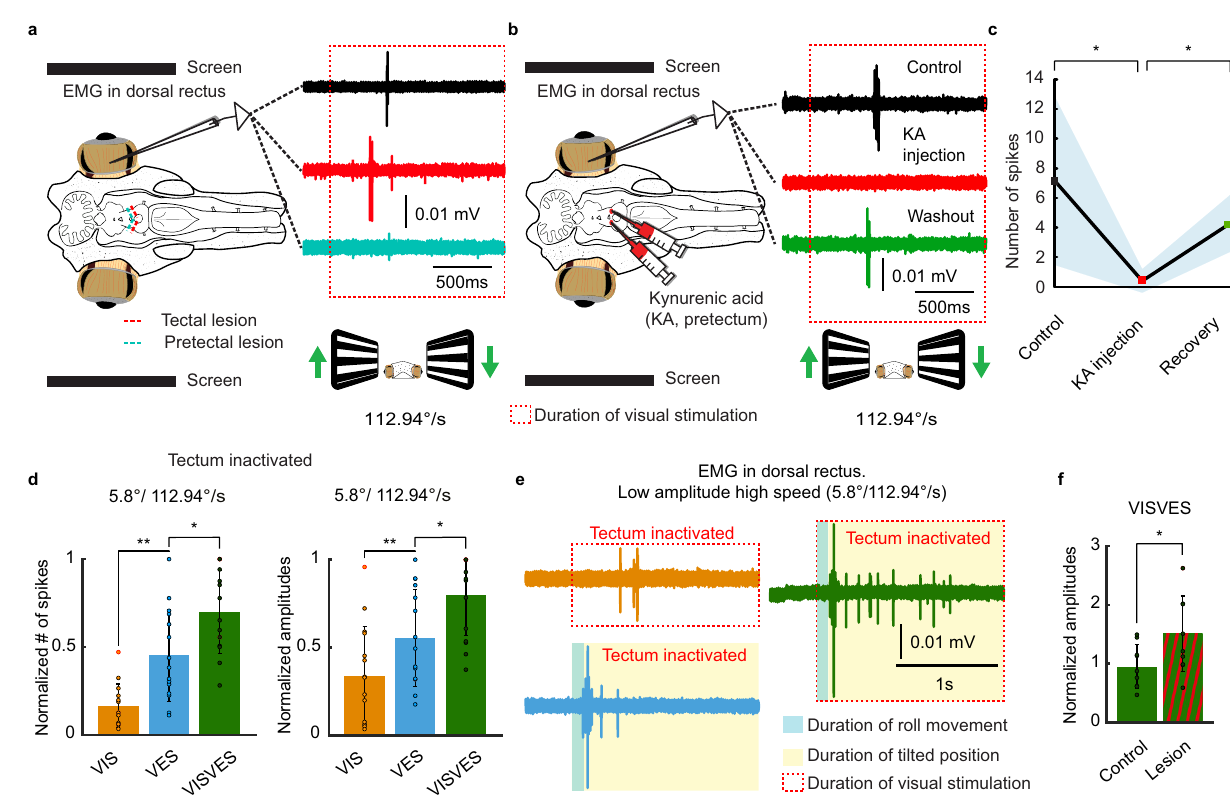
Fig. 6 | Optokinetic responses are mediated by pretectum and downregulated by tectum. a EMG responses in the dorsal rectus to optokinetic stimulation in an intactbrain(blacktrace)andafterpreciseinactivationofthevisualinputtotectum (red trace) and pretectum (blue trace). b EMG responses in the dorsal rectus to a visual stimulus in an intact brain (black trace) and after precise pharmacological inactivation with kynurenic acid of pretectum leading to the abolishment of the optokineticre fl ex(redtrace),whichreturnedafterawashout(greentrace).Thered dotted rectangle indicates the duration of the visual stimulation. c graph showing the signi fi cant reduction in dorsal rectus activity in response to optokinetic sti- mulation after pretectal inactivation with kynurenic acid (KA; t(6)=2.633, p =0.039, n =7 recordings from three animals), and the signi fi cant recovery after washout(t(3)= − 3.703, p =0.034, n =4recordingsfromthreeanimals).Theshaded area denoteserror bands. d Graphsshowing thenormalized EMGamplitudes(left) and spikes (right) to visual (VIS), vestibular (VES), and visuovestibular (VISVES)